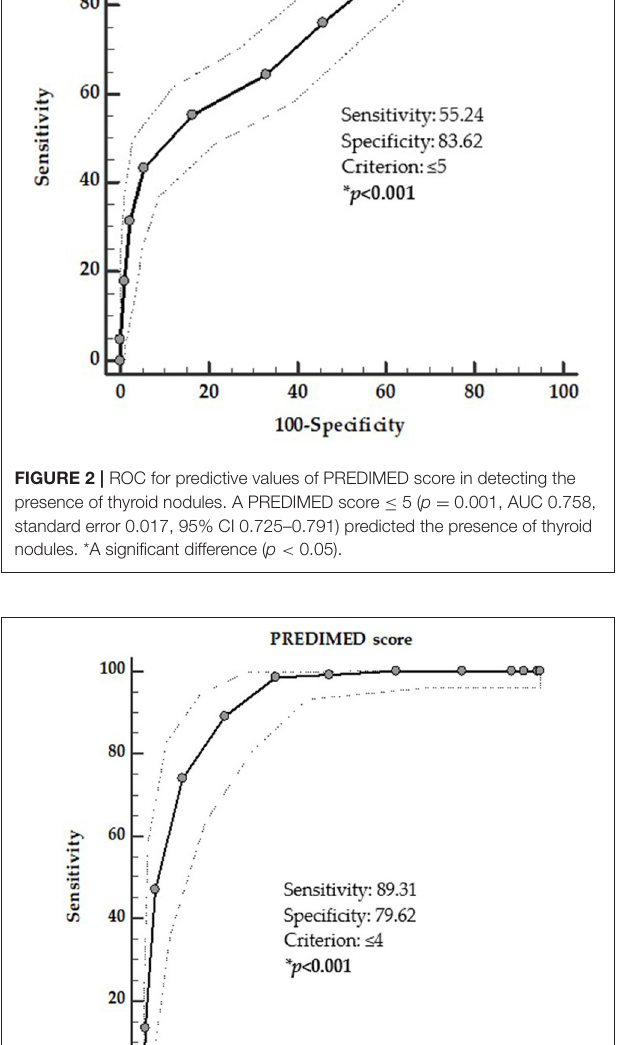
18% of the study participants presented TIR2, while ∼ 9 and 8% of the participants had high-risk categories, TIR4 and TIR5, respectively. The high-risk category (TIR4/TIR5) increased along the BMI categories. In particular, in class II obesity 54.9%